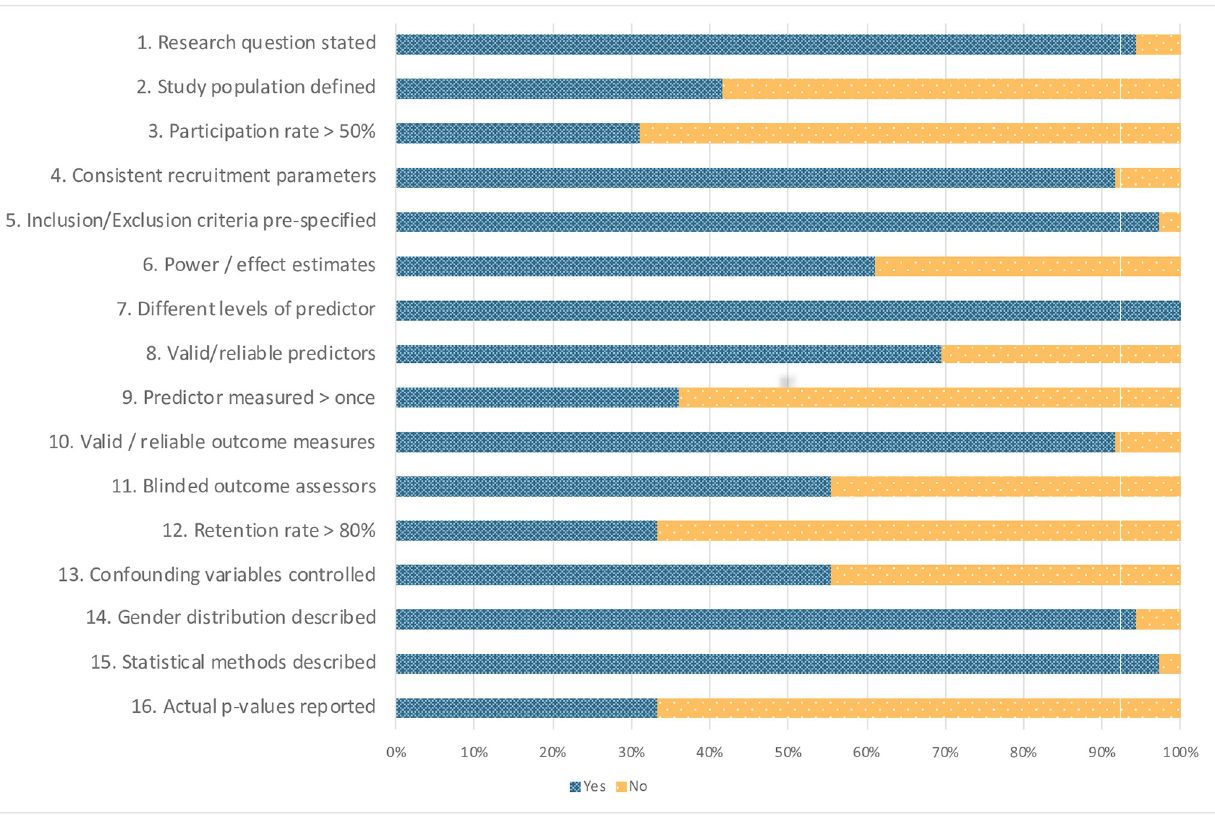
Fig 2. Quality assessment scores. Percentage of studies that fulfilled the criteria for each item on the quality assessment checklist.